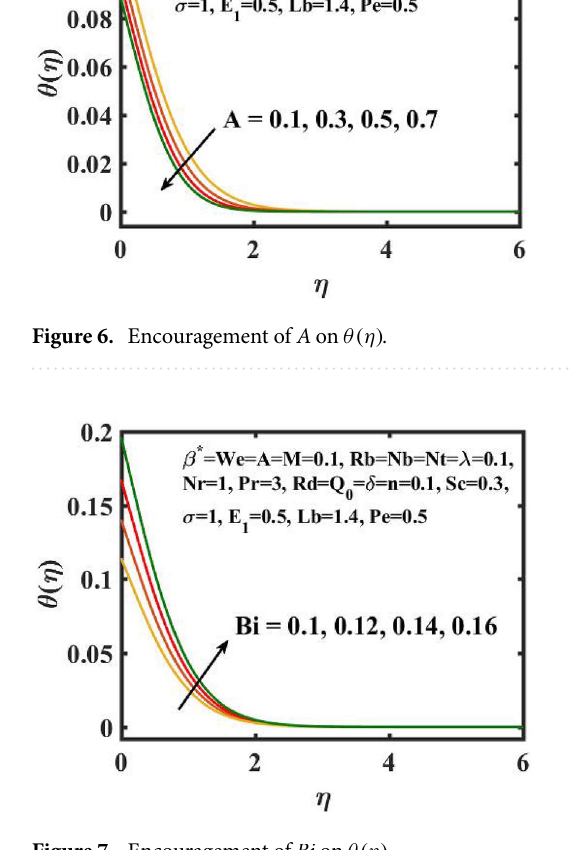
Figure 7. Encouragement of Bi on θ(η) .